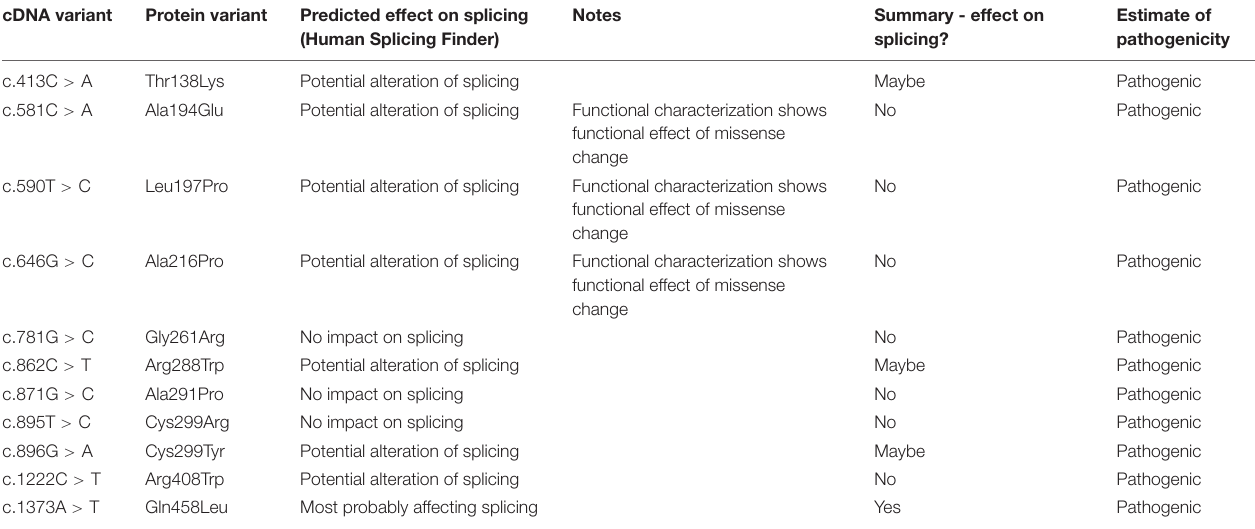
TABLE 2 | Mutations in PRPF31 annotated as missense, and their predicted impact on splicing. cDNA